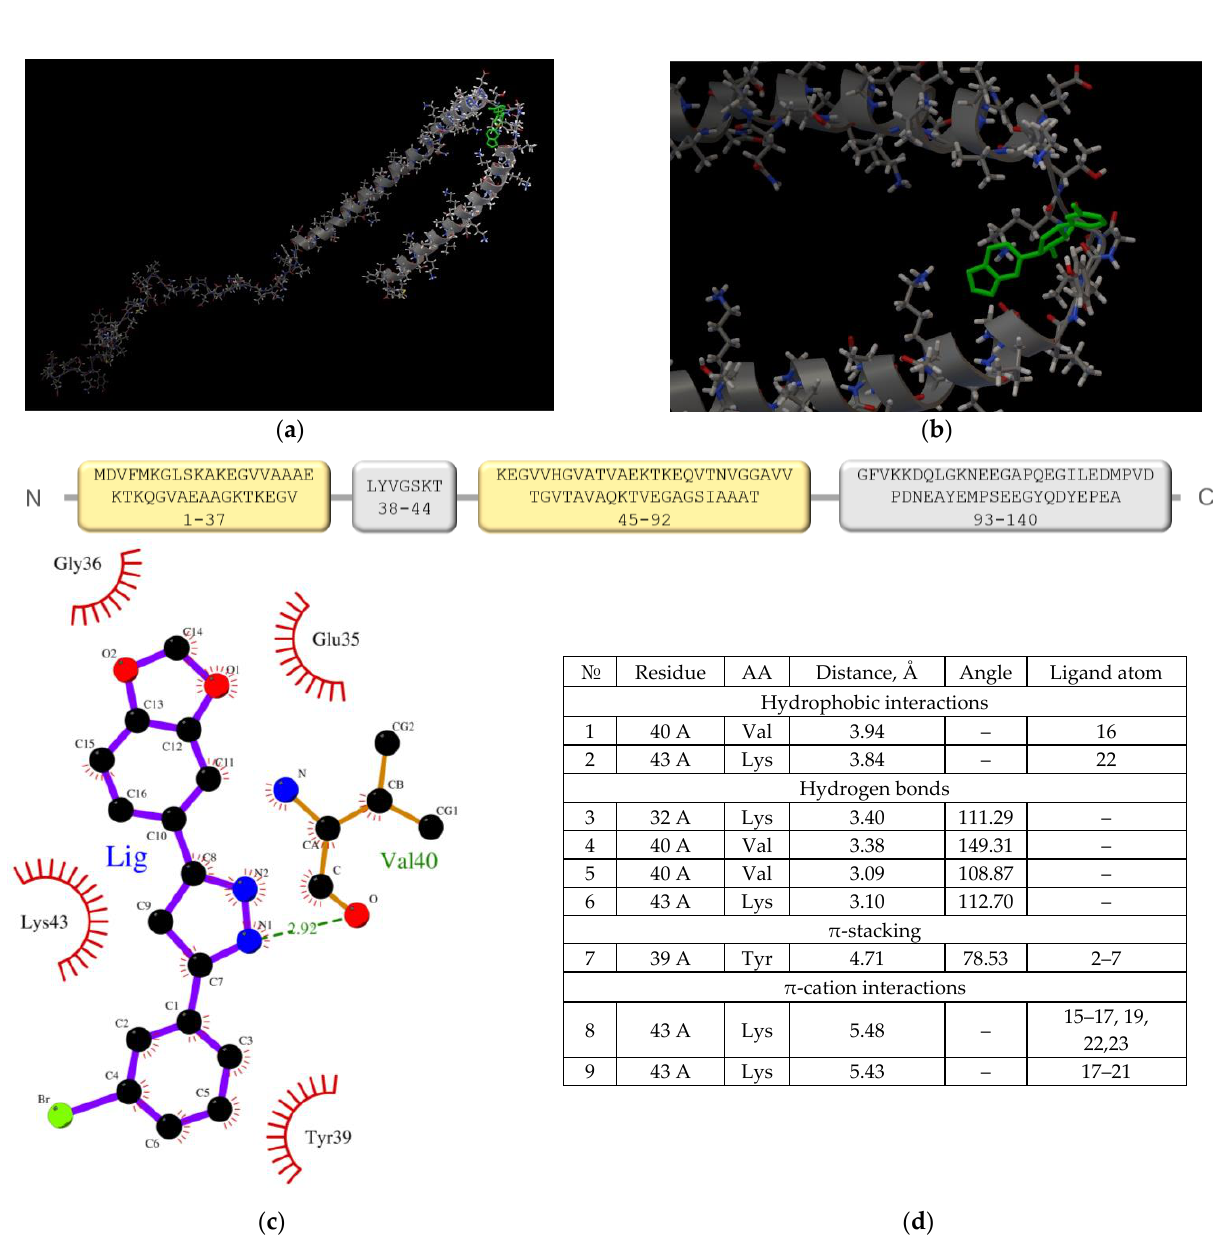
Figure 2. ( a , b ) Anle138b molecule binding to full-length alpha-synuclein molecule (PDB ID 1XQ8). The 3D structure of the Anle138b ligand is indicated in green. ( c ) Interactions diagram of Anle138b with a fragment of the alpha-synuclein monomer. ( a ) full image size, ( b ) enlargement of the binding site image. The figure above shows the amino acid sequence of AαSyn, the blocks reflect the organization of secondary structure elements: yellow blocks correspond to alpha helices, gray blocks correspond to unstructured regions (coil). ( d ) Interaction options for Anle138b binding to the alpha-synuclein monomer (PDB ID